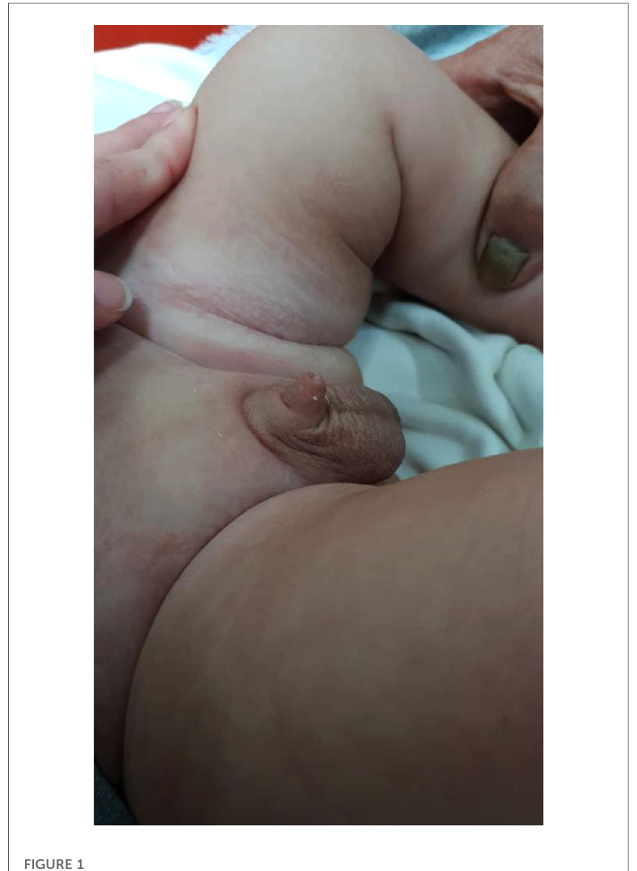
FIGURE 1 Concealed